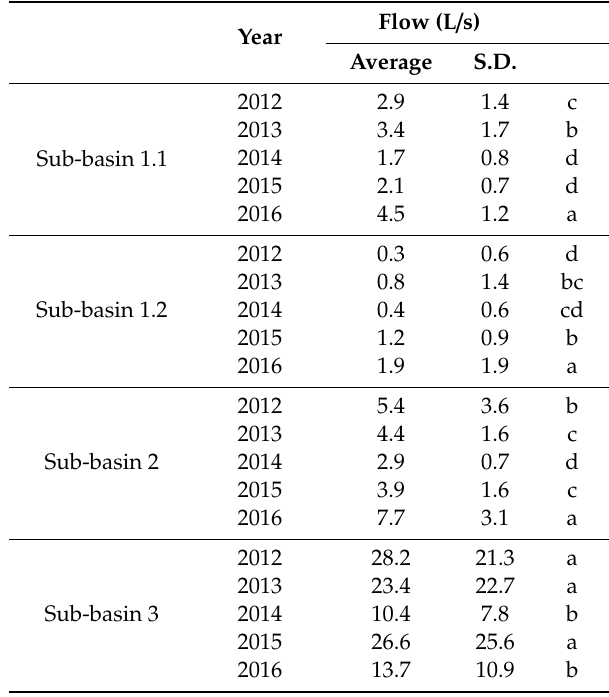
Table 3. Sub-basins 1.1., 1.2, 2, and 3 flows (m 3 / s) in the Olaria stream watershed.